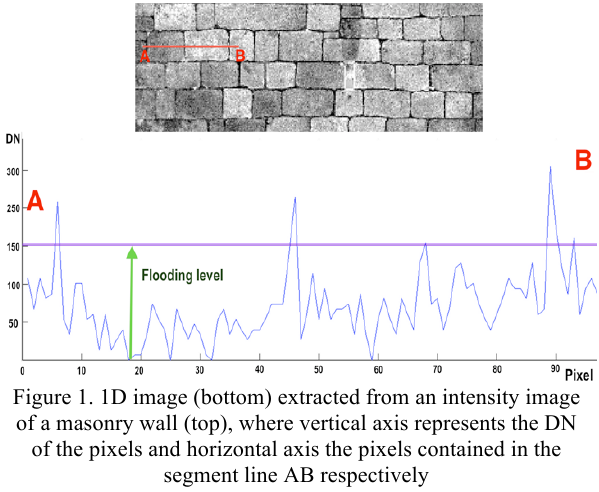
Figure 1. 1D image (bottom) extracted from an intensity image of a masonry wall (top), where vertical axis represents the DN of the pixels and horizontal axis the pixels contained in the segment line AB